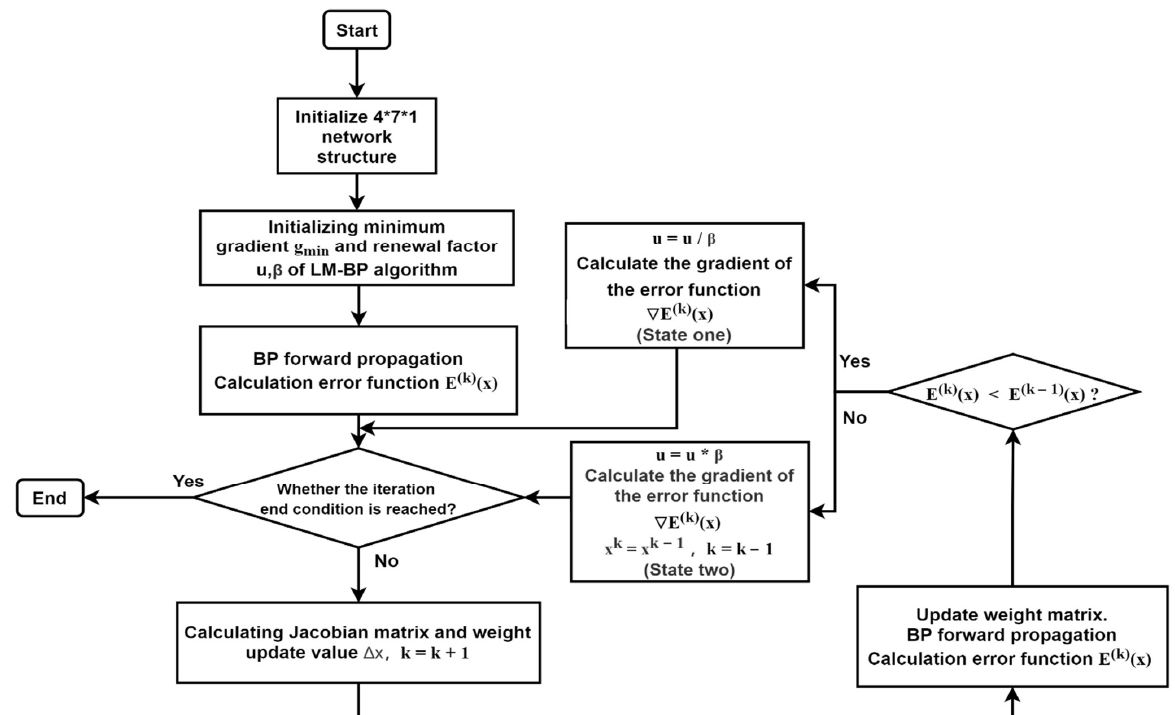
Figure 7. Optimization of the BP algorithm flow chart by the Levenberg–Marquardt (LM) algorithm.